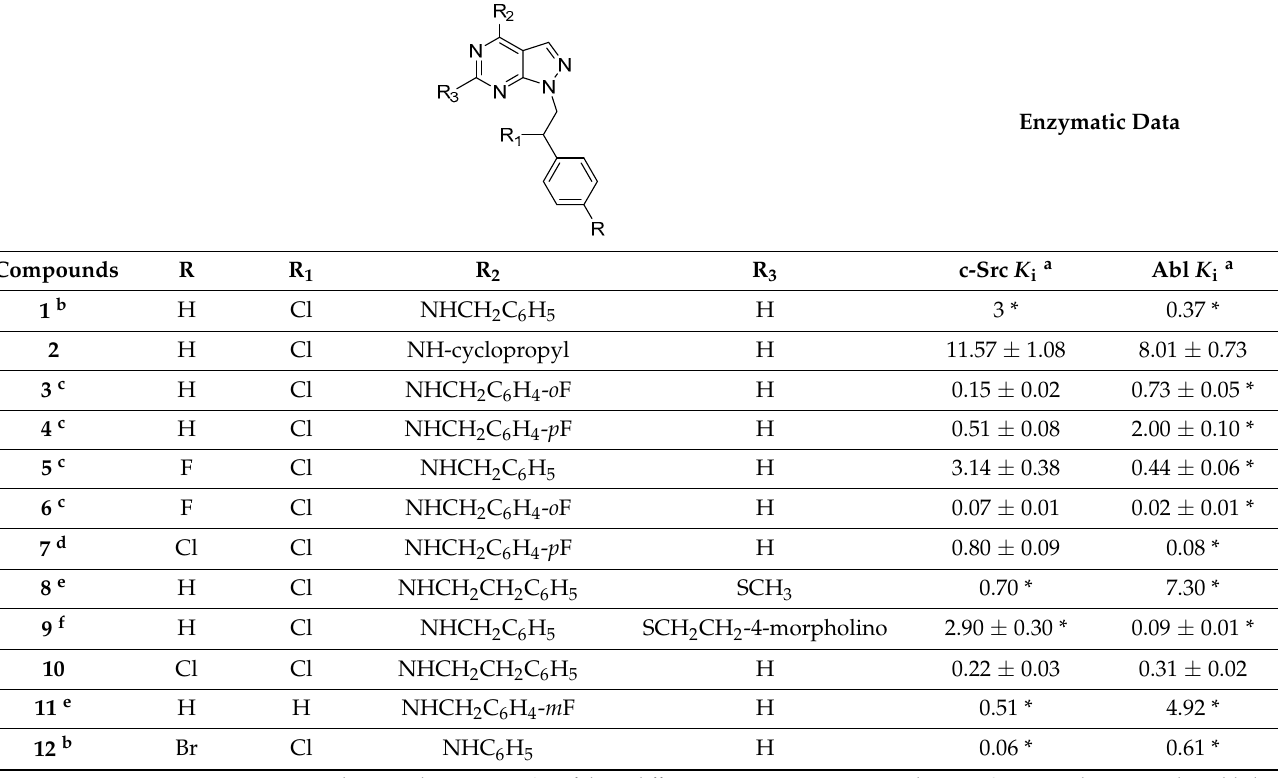
Table 1. Chemical structures and enzymatic activity ( µ M) against c-Src and Abl of compounds 1 – 12 .